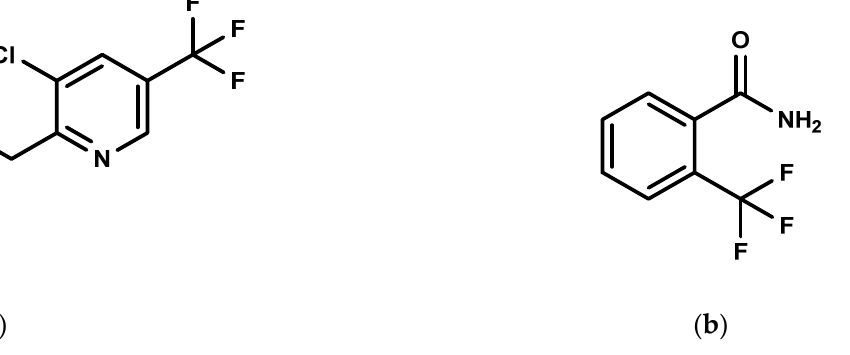
Figure 1. ( a ) The chemical structure of fluopyram ; ( b ) The chemical structure of fluopyram-ben- zamide .